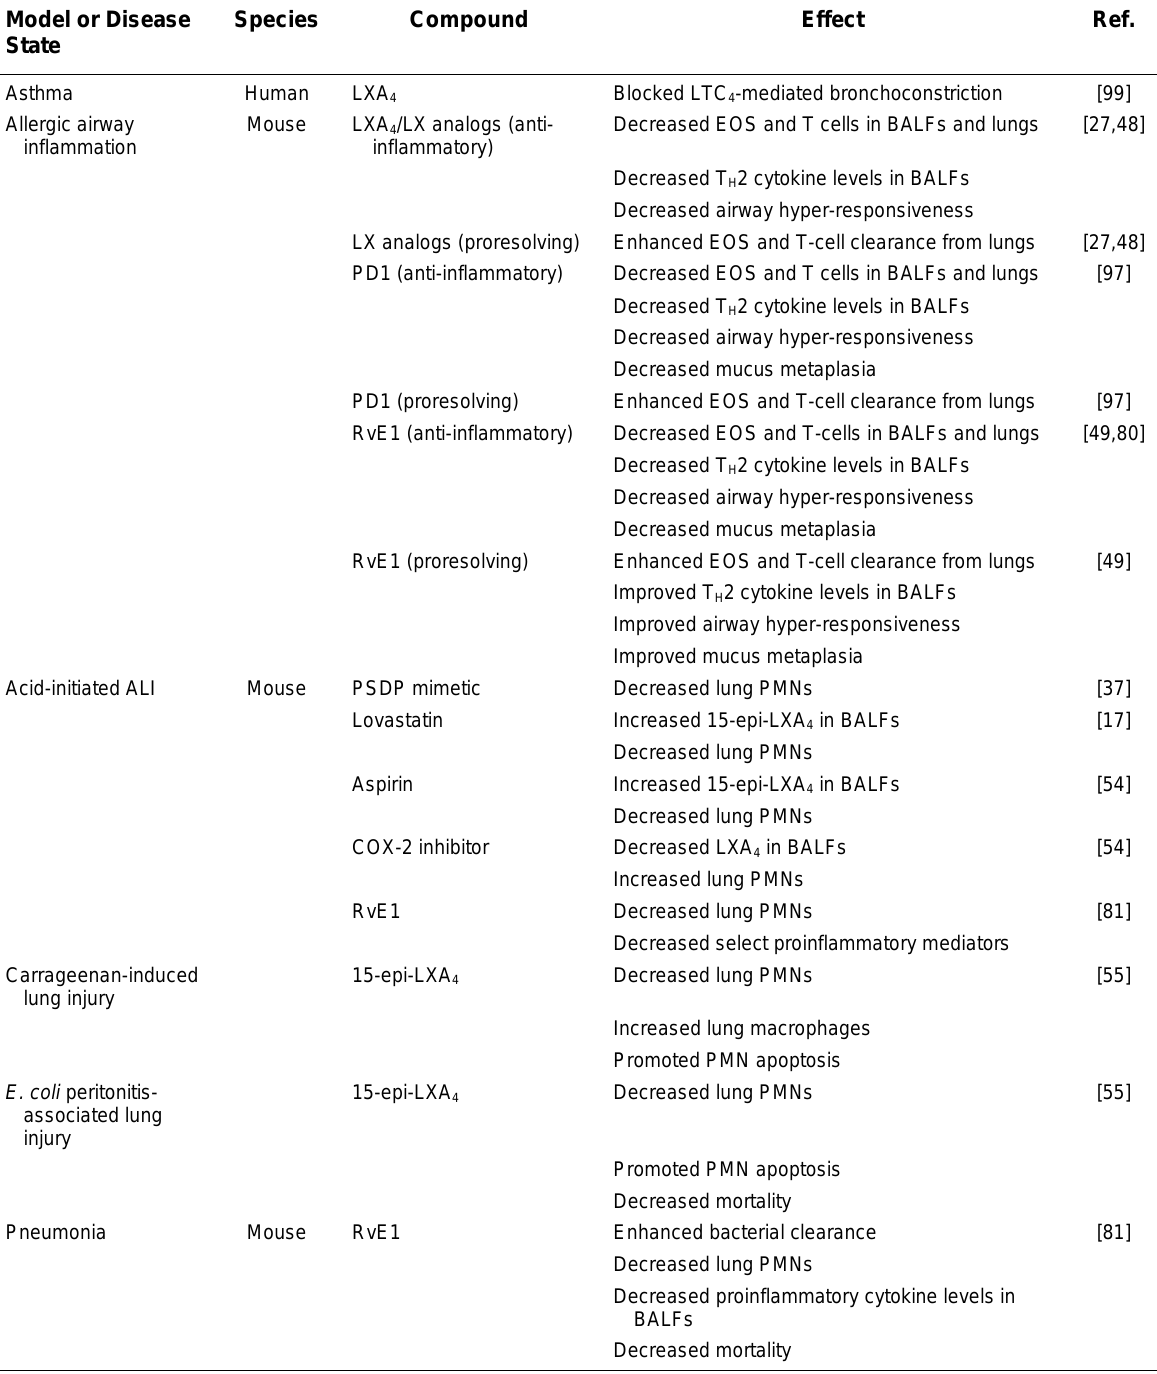
Effects of Anti-Inflammatory and Proresolving Mediators on Human Lung Disease and Murine Models of Lung